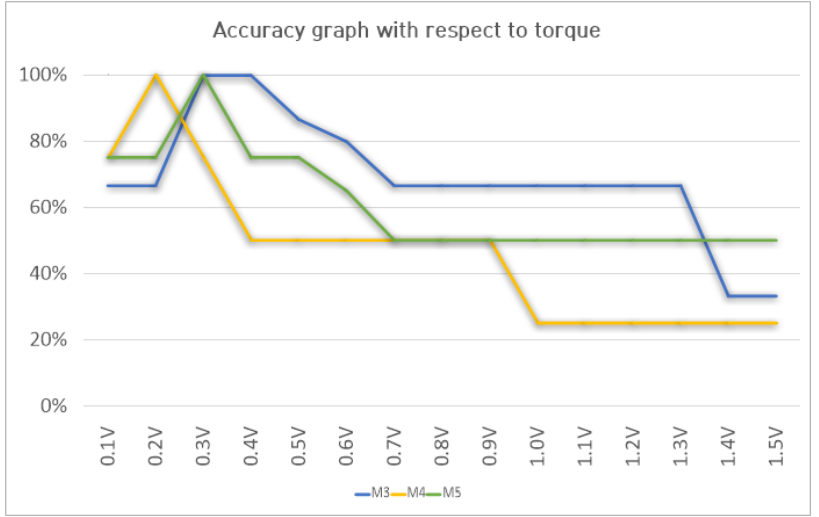
Figure 12. Accuracy graph (in percent) as the threshold δ